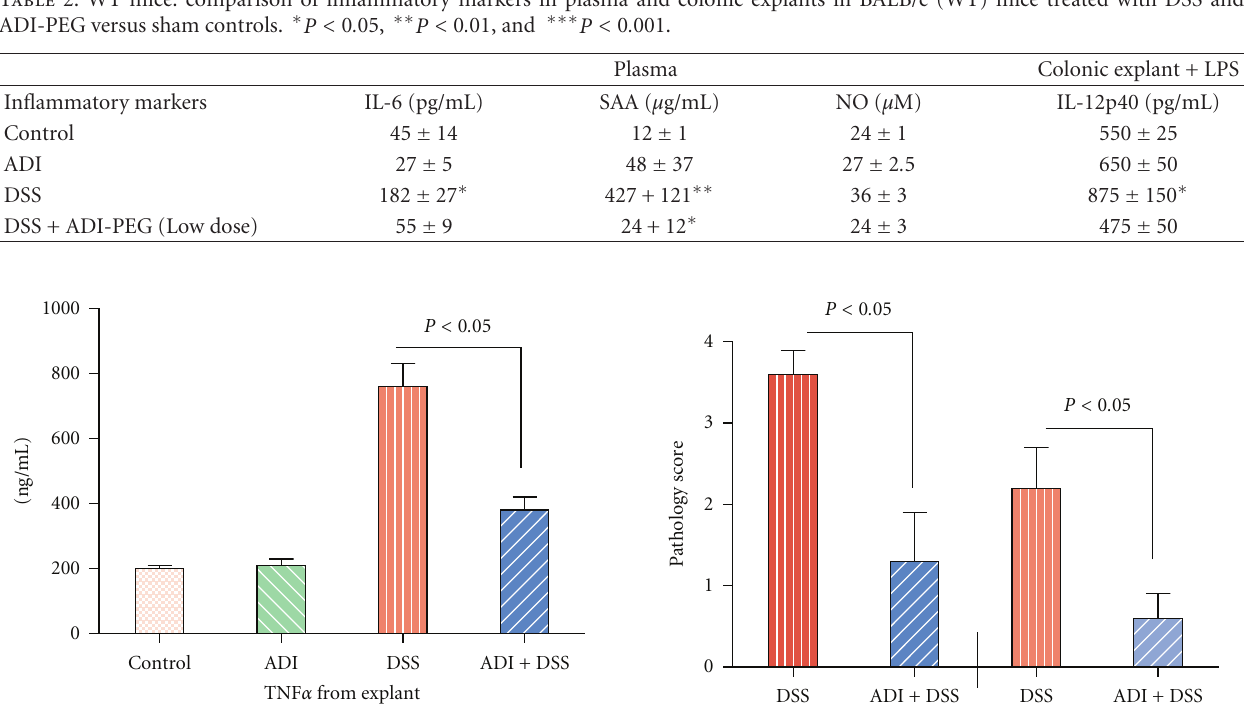
Figure 2: ADI-PEG treatment significantly decreased inflammatory response to LPS-stimulated TNF α production by colonic explants ( P < 0 . 05). Figure 3: E